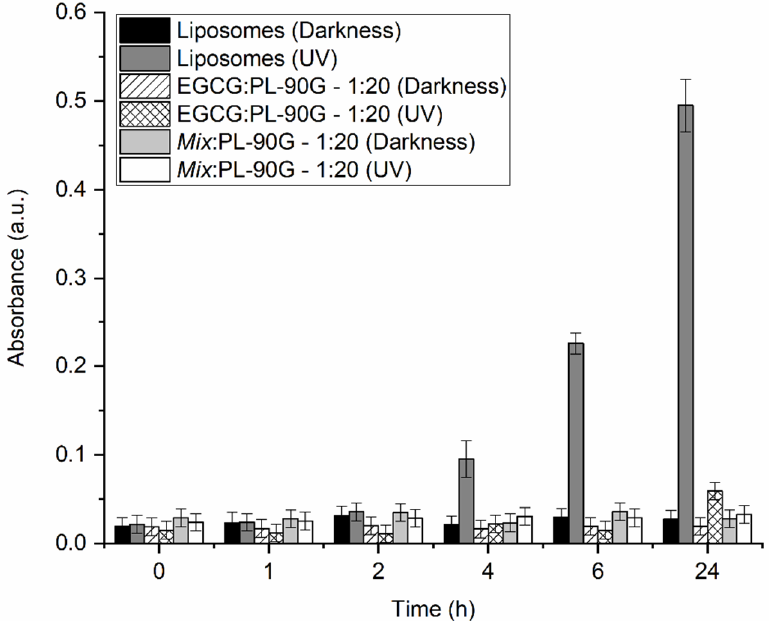
Figure 10. Peroxidation of phospholipon PL-90G (PL-90G) liposomes in 20 mM HEPES (pH = 7.0) buffer without (Liposomes) or with the addition of (-)-epigallocatechin-3-gallate (EGCG) or a mixture of chrysin, caffeic acid, trans -ferulic acid, quercetin, and EGCG ( Mix ) at w EGCG/ Mix : w PL-90G = 1:20 mass ratio, as obtained by the thiobarbituric acid reactive species assay. The mass ratio of compounds in the Mix was w chrysin : w caffeic acid : w trans -ferulic acid : w quercetin : w EGCG = 1:1:1:1:1. Darkness—samples kept in darkness (negative control); UV—samples exposed to the ultraviolet light (254 nm).